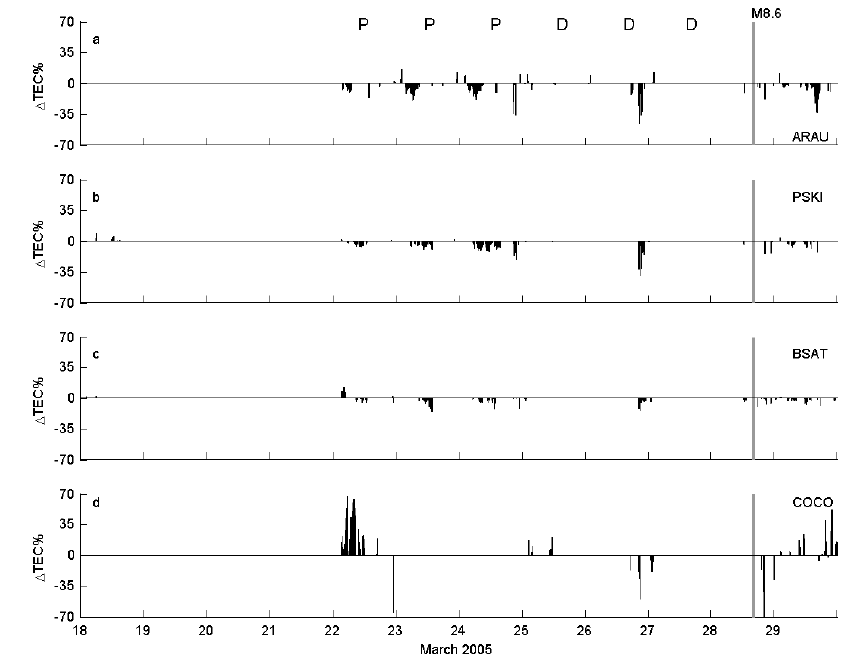
Fig. 6. The percentage of TEC deviation between 21 and 29 March 2005 at 4 GPS stations.